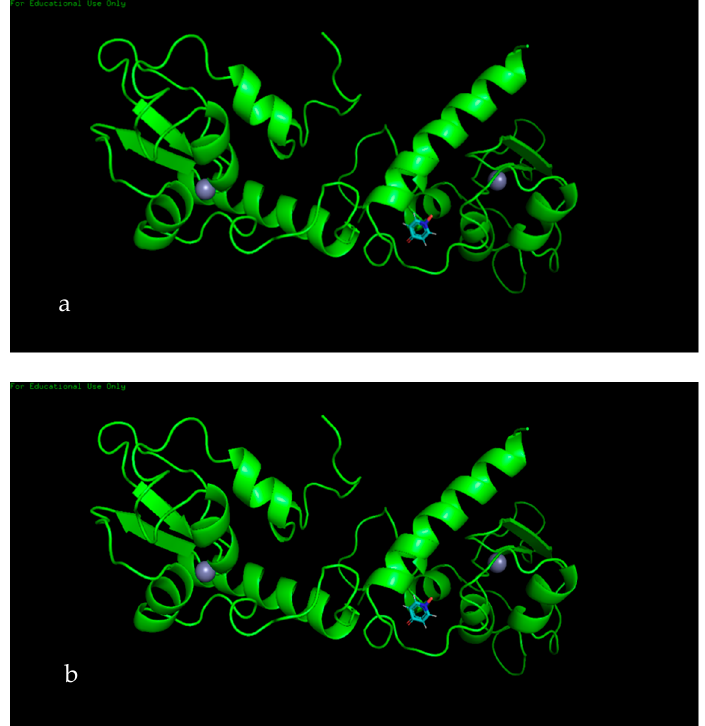
Figure 6. The three-dimensional surface structure forming a complex between survivin protein and ligand 4-hydroxypyridine 1-oxide active site 1 ( a ) and active site 2 ( b ). It clearly shows the ligand (blue) occupying the active sites’ gorge via van der Waals forces (red).